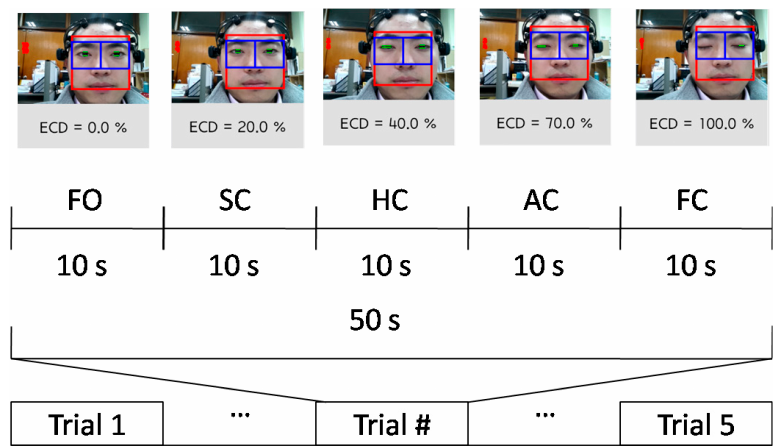
Figure 1. Trial structure adopted in the experimental